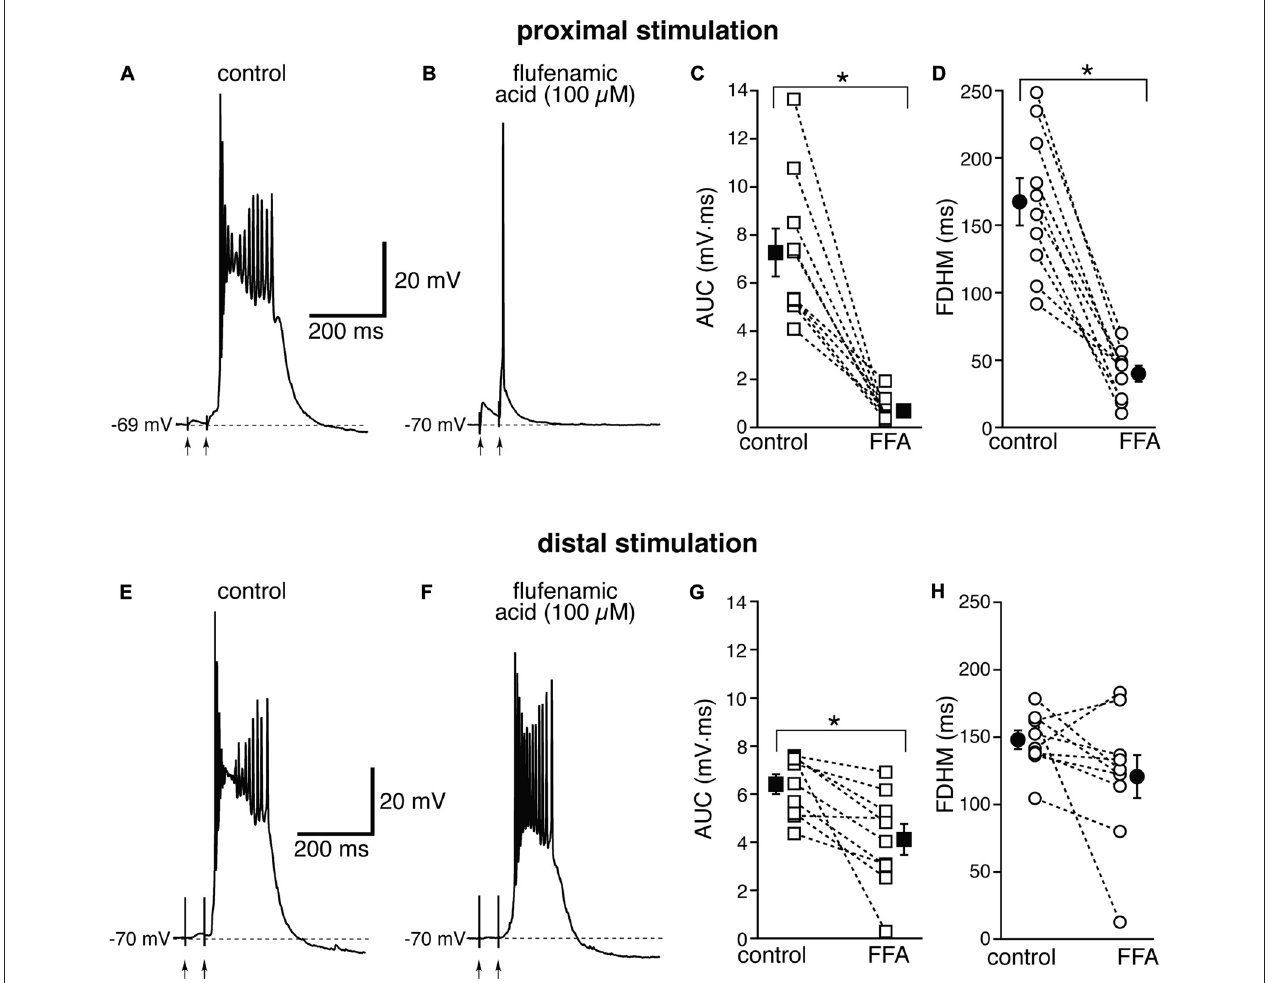
FIGURE 6 | The effect of flufenamic acid (FFA) on the depolarizing plateau and hyperexcitability differs depending on the location of the stimulation. Top, representative trace of the response elicited by synaptic stimulation in control conditions (A) and in the presence of FFA (100 µ M, B ) for proximal synaptic stimulation. Strikingly, the perfusion of FFA changes the response from a burst into a single AP. This fact is reflected in the marked average decrease of the AUC ( C , by 88 ± 4%) and the FDHM ( D , by 74 ± 5%) in n = 10 neurons. Bottom, representative trace of a burst recorded upon stimulation of distal afferent fibers in control conditions (E) and in the presence of FFA (F) . FFA switched the response from a burst to a single AP in only one neuron. In addition, on average FFA reduced the AUC (G) by only 35 ± 9%, and the FDHM (H) by only 17 ± 11% in n = 10 neurons. Asterisks indicate significant difference between control and FFA treatment. There was a statistically significant interaction between the FFA treatment and location for both the AUC ( p < 0.0005) and the FDHM ( p = 0.002, two-way mixed ANOVA). The traces in (A,B) and (E,F) were recorded from two separate neurons.